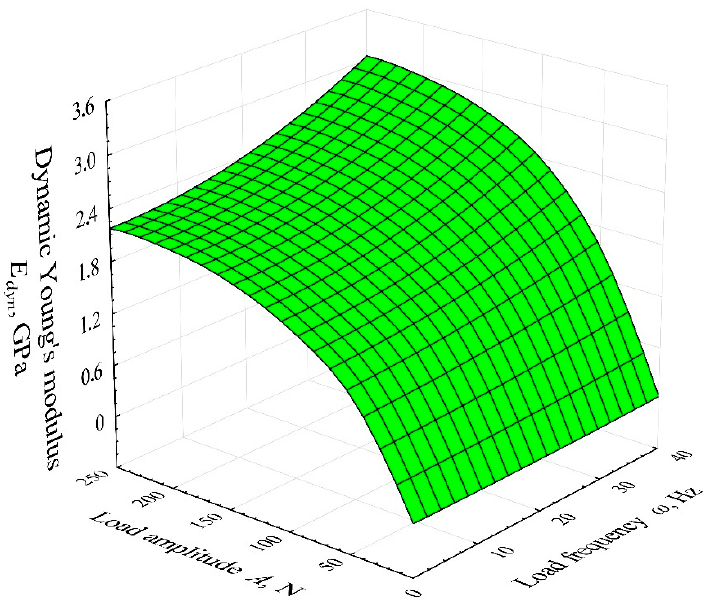
Figure 6. The modelled nonlinear nature of the dynamic Young’s modulus, E dyn model , depending on the frequency ω and amplitude A of nonstationary load.